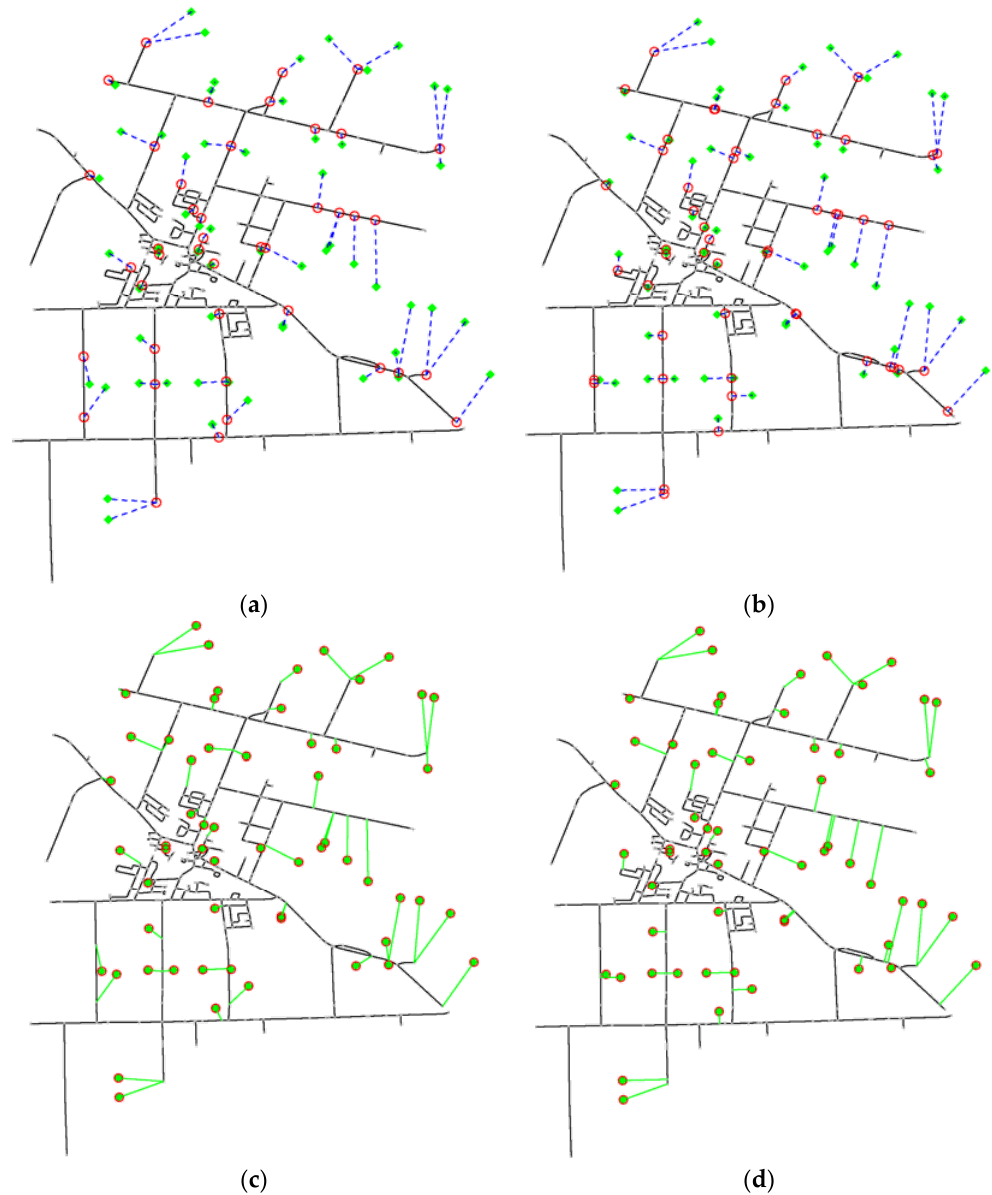
Figure 10. Examples of integrating points/locations with a spatial network (Ontario road data), where green dots represent points given, a blue dash in ( a , b ) indicate the closest relationship between a point and its nearest vertex/position on the network, green lines in ( c , d ) mean the edges newly added and red circles mark the representative vertices. ( a ) Solution with strategy 1; ( b ) Solution with strategy 2; ( c ) Solution with strategy 3; ( d ) Solution with strategy 4.